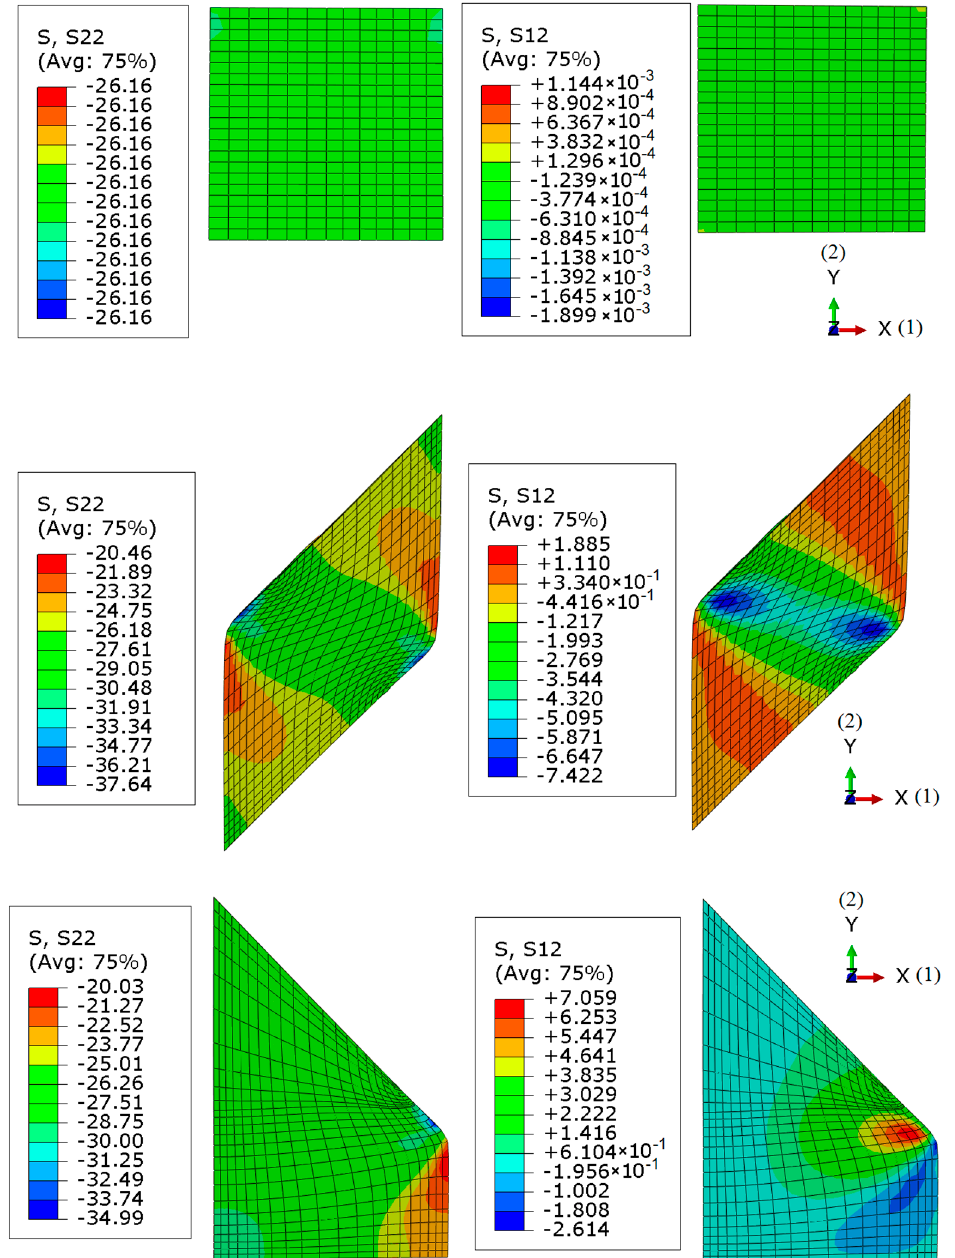
Figure 6. Stress distribution for axial and shearing stress for selected configuraions.